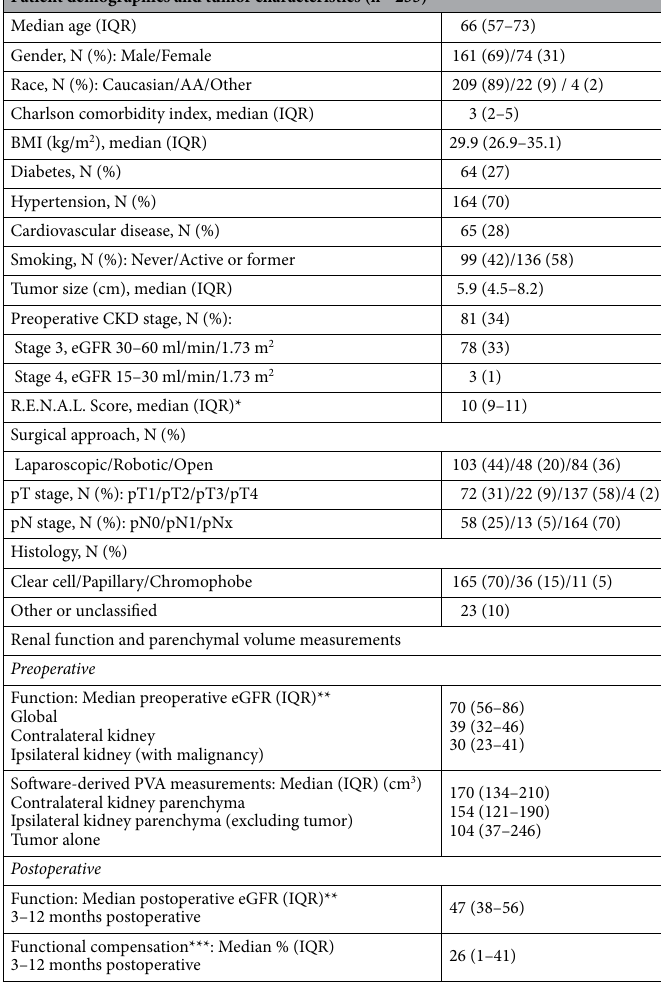
Table 1. Patient characteristics and renal functional parameters. AA African–American, BMI body mass index; CKD chronic kidney disease; eGFR estimated glomerular filtration rate; IQR interquartile